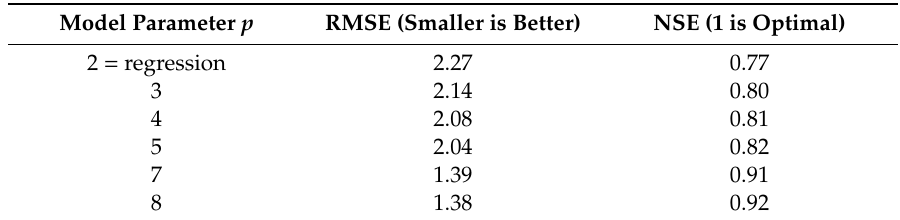
Table 5. Root mean square error (RMSE) and Nash–Sutcli ff e model e ffi ciency of stream model at Station 412002 (model p = 2 is a simple regression model between air and water temperature). Model parameter p according to Piccolroaz et al. [67].